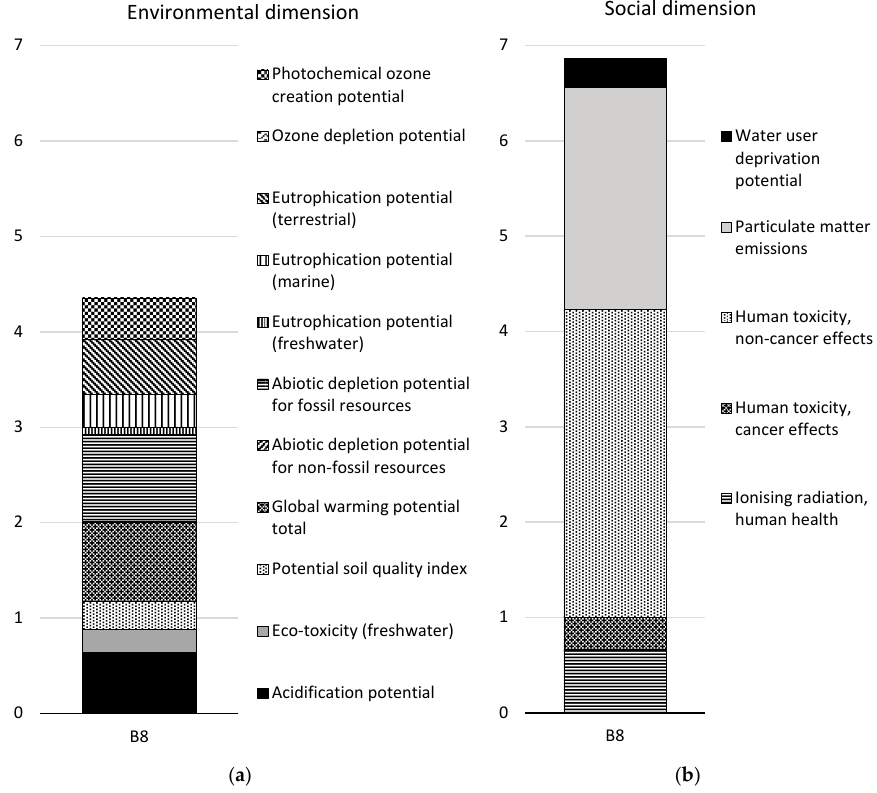
Figure 3. Contribution of resources to the total impact over the life cycle (modules A–C, excluding B8) for the CSF bridge design concept in the environmental and social dimensions.